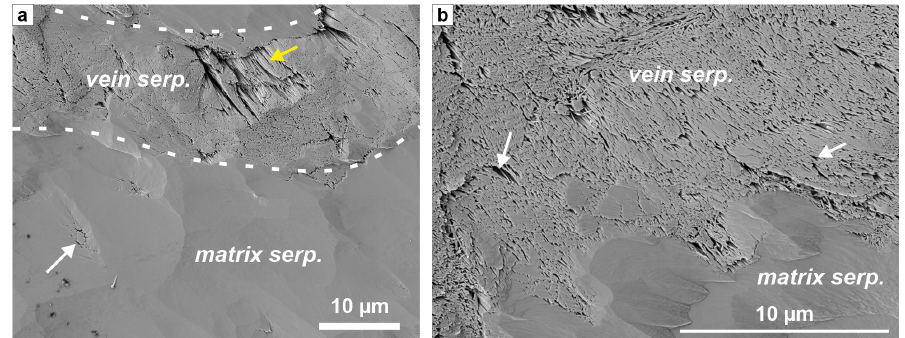
Figure 12. SE image of a broad-ion-beam polished serpentine vein in foliated serpentinite (a) with a close-up of the vein–wall rock inter- face (b) , showing that the vein serpentine is highly (nano-)porous in comparison to matrix serpentine. White arrows indicate examples of nano-porosity (black). In the vein, porosity is controlled by fibrous serpentine as seen in the poorly polished area (yellow arrow in a ). The vein domain corresponds to the blue bands in Fig. 2d (sample